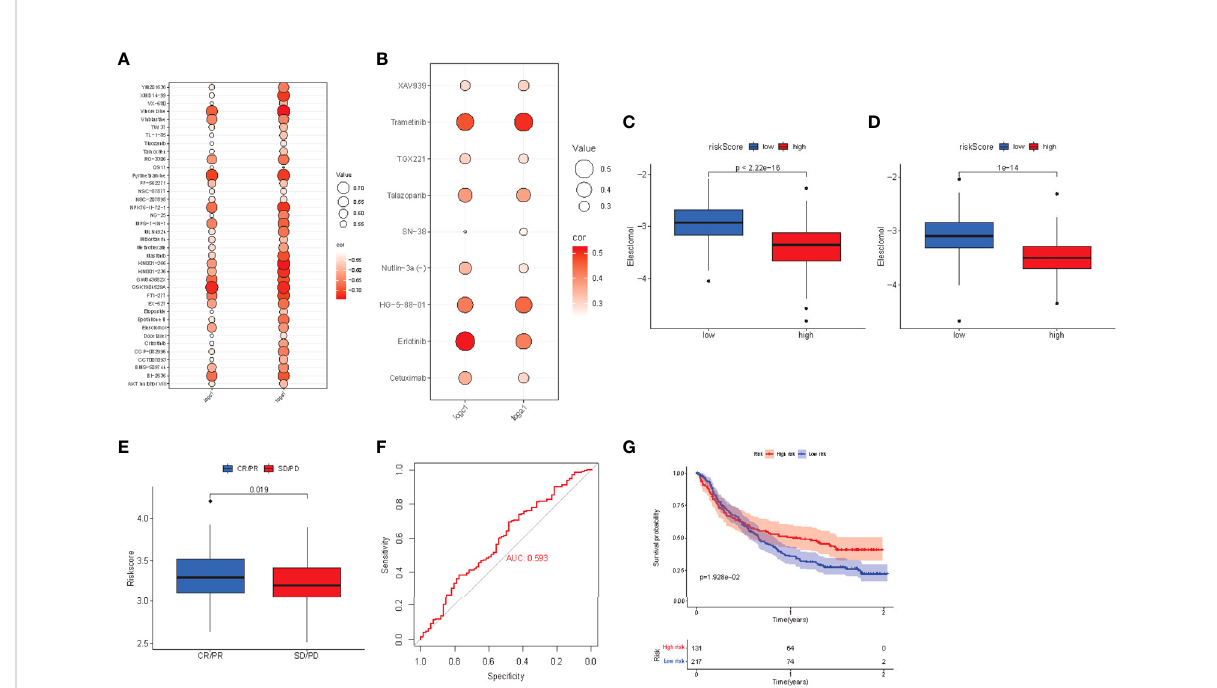
FIGURE 9 (A) Bubble chart of negative correlation between estimated IC50 value and risk score of 38 drugs. (B) Bubble chart of positive correlation between estimated IC50 value and risk score of 9 drugs. (C) Box plot of the estimated IC50 values of eleshomol in the high-risk and low-risk groups of the TCGA cohort. (D) Box plot of the estimated IC50 values of eleshomol in the high-risk and low-risk groups of the ICGC cohort. (E) Box plot of correlation between immunotherapy and risk score in imvigor210 cohort. (F) ROC curve of risk score to predict the effect